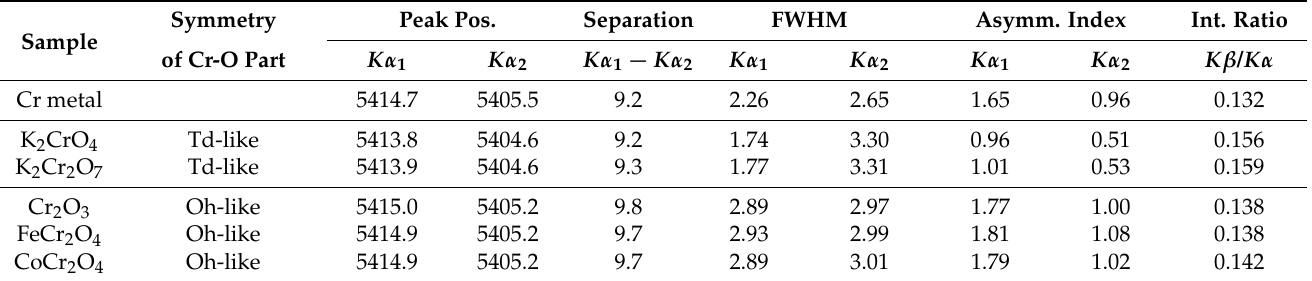
Figure 4. Cr K α 1,2 spectral lines in Cr 2 O 3 ( left ) and K 2 CrO 4 ( right ) compounds measured using a high resolution double-crystal X-ray spectrometer. Oh symmetry represents ionic bonds, while Td symmetry represents covalent bonds. The spectral profiles show the differences in the energy values, half widths, and asymmetry indices. Table 4. Cr K α 1,2 peak positions, energy difference between the two peaks (eV), half-width (eV), asymmetry index, and K β / K α intensity ratio.